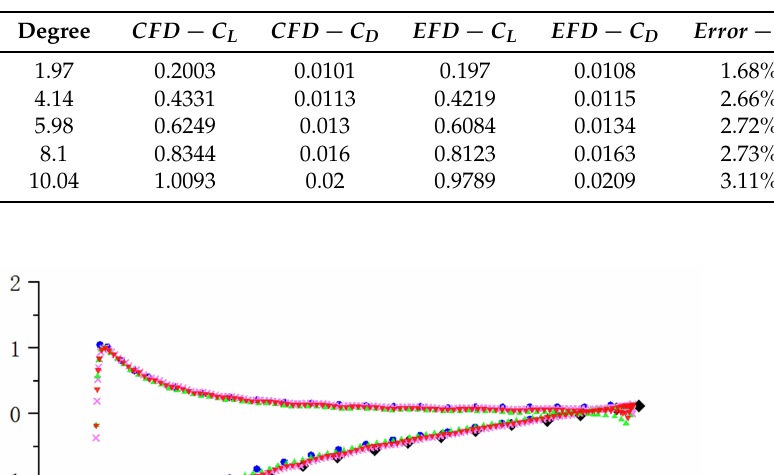
Table 4. Comparison of the lift and drag coefficients.